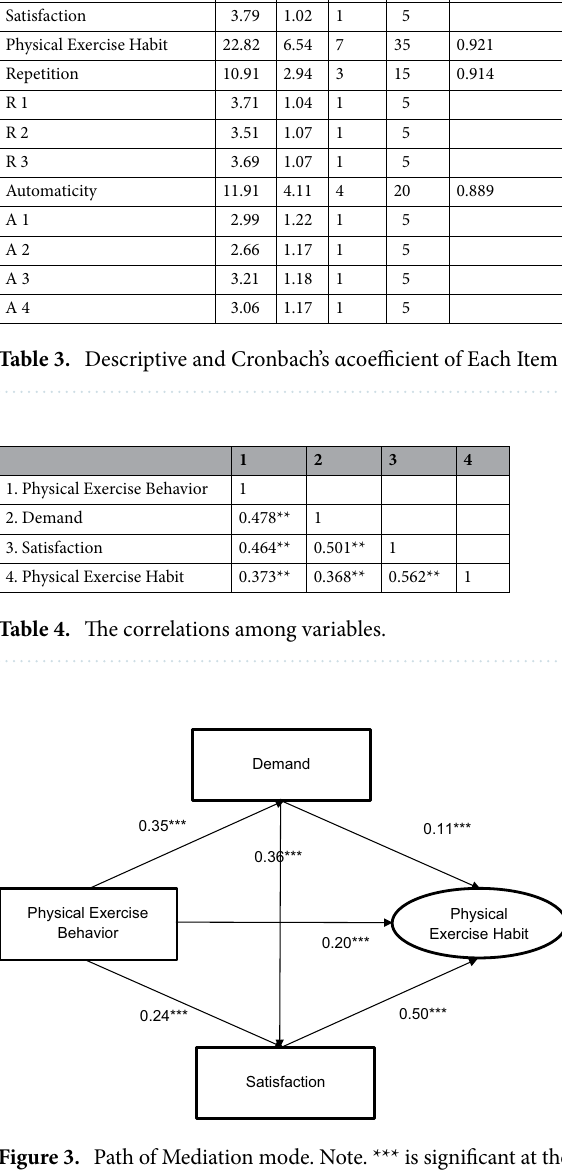
Figure 3. Path of Mediation mode. Note. *** is significant at the 0.001